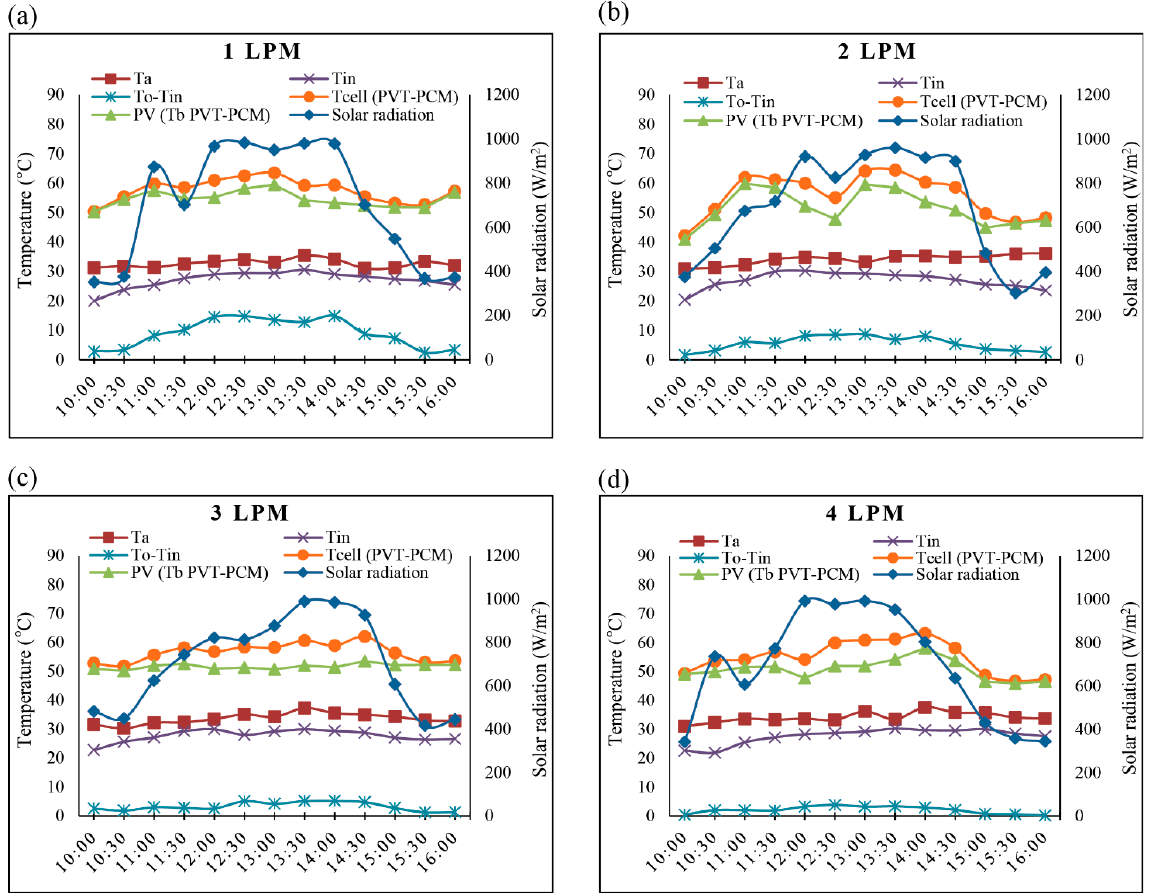
Figure 3. Daily variation of PVT-PCM parameters at ( a ) 1 LPM, ( b ) 2 LPM, ( c ) 3 LPM, and ( d ) 4 LPM flow rate. flow